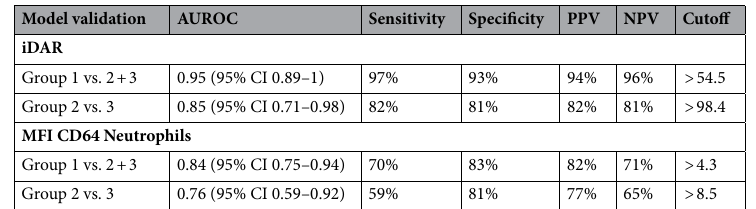
Table 2. Validation in iDAR in 3 ICU subgroups. AUROC, sensitivity, specificity, positive and negative predictive values (PPV, NPV) are shown at the indicated cutoffs. The performance of CD64 MFI on the same cohort is presented for